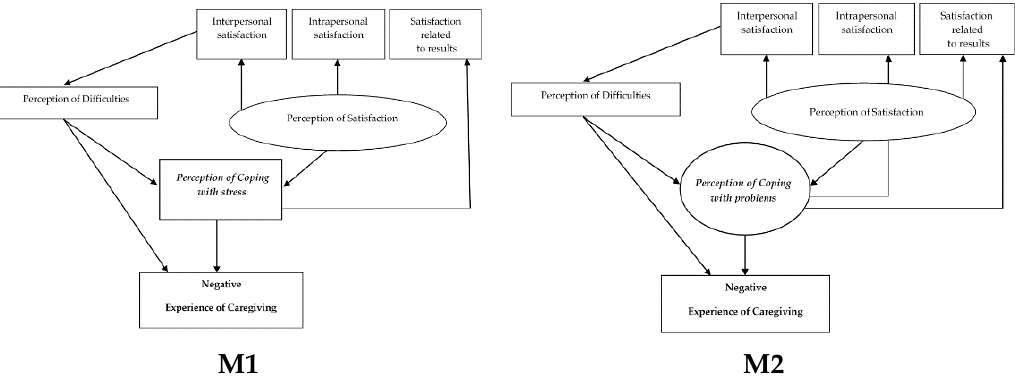
Figure 1. Hypothesized theoretical models for negative experience of caregiving.